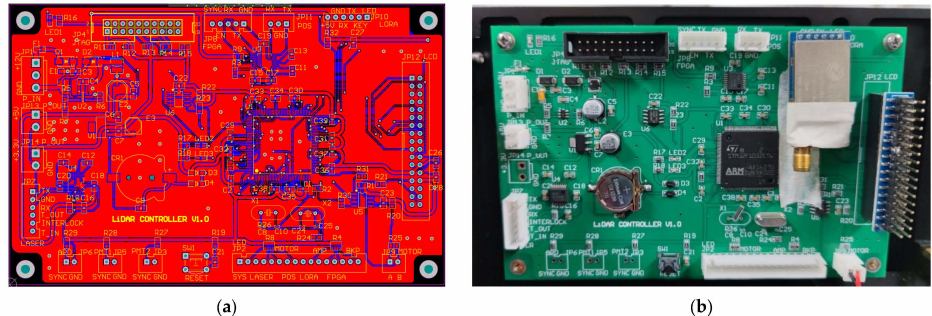
Figure 11. ( a ) Top view of the PCB and ( b ) the physical diagram of the control